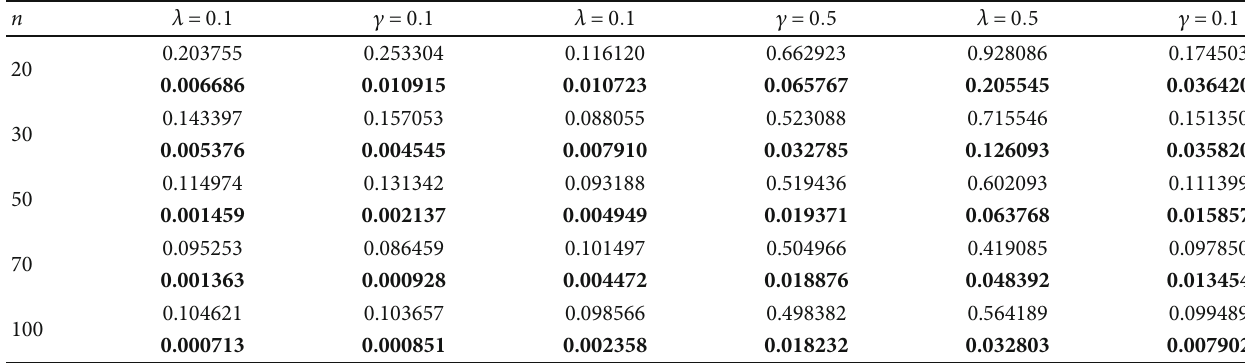
Table 6: BEs and PRs under PLF and informative prior using λ = 0 : 1, 0 : 5 and γ = 0 : 1, 0 : 5